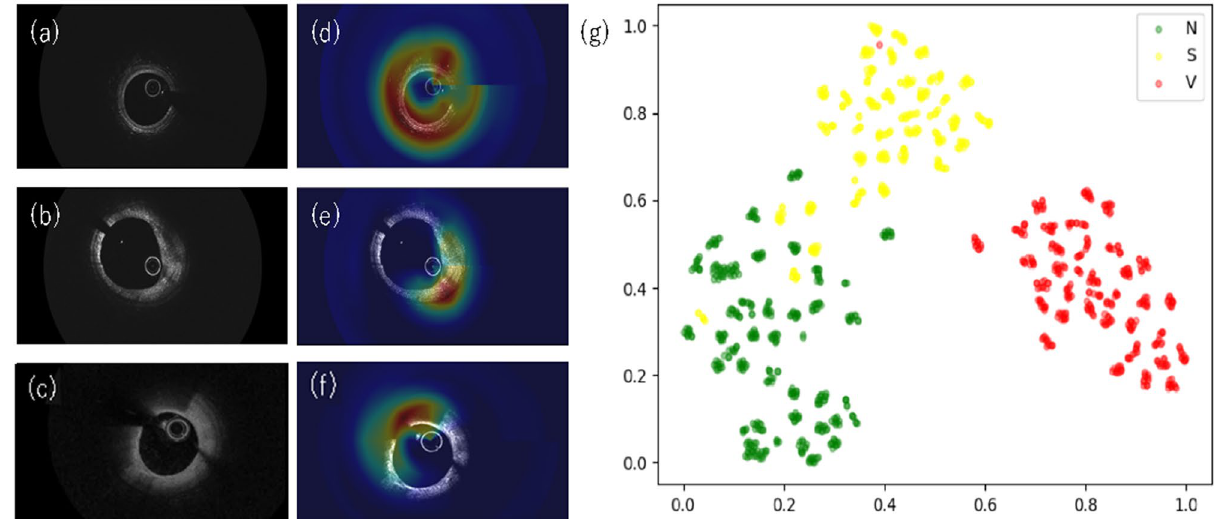
Figure 3. Grad-CAM analysis and t-SNE visualization of the last hidden layer for the three types of OCT imaging. Normal ( a ), stable ( b ), and vulnerable ( c ) OCT images. ( d–f ) Images of ( a–c ) overlaid with the attention map output by Grad-CAM. Expert cardiologists usually differentiate vulnerable plaque from stable plaque based on the thickness of the fibrous cap overlying the lipid component in OCT image. It is interesting to note that for stable and vulnerable plaques, the attention is on a part of the fibrous cap overlying the lipid component, whereas for normal plaques, the attention is given to the whole vessel wall in the attention map output by Grad-CAM. The high-dimensional features obtained by DenseNet-121 are dimensionally compressed by t-SNE and are represented as two-dimensional data ( g ). A total of 1,173 images of the test dataset that was obtained from 102 patients are displayed. Normal (N), stable plaque (S), and vulnerable plaque (V) images are represented as green, yellow, and red dots, respectively. The normal, stable plaque, and vulnerable plaque clusters are clearly observed. Some stable plaque data are included in the normal cluster, which is consistent with the results of the confusion matrix (Fig.